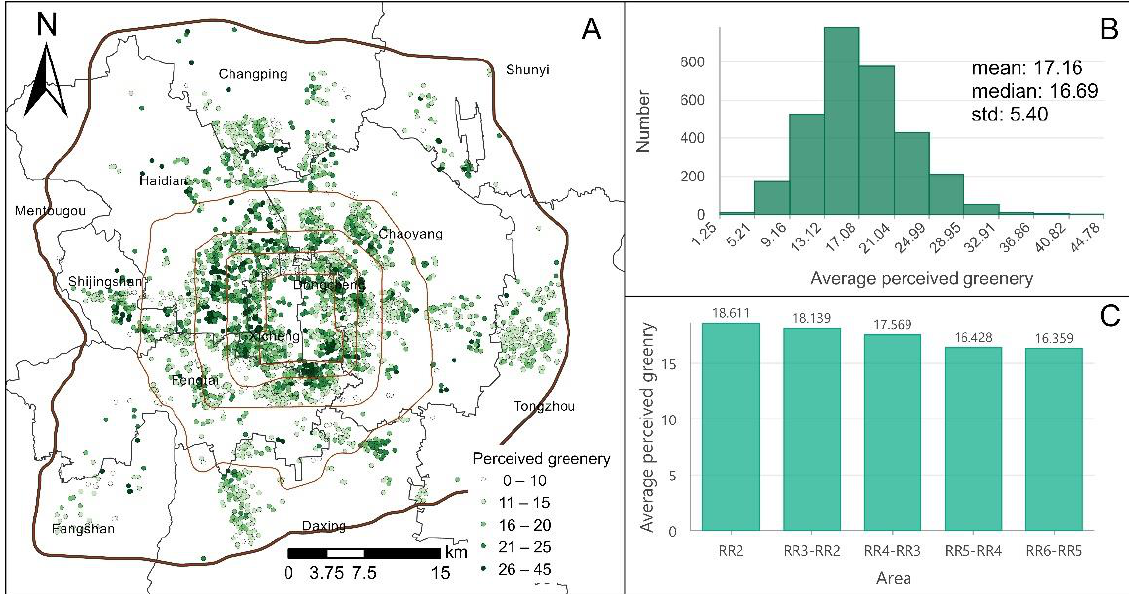
Figure 4. The perceived greenery distribution map and statistics in Beijing. Subplot ( A ): the perceived greenery distribution map. Subplot ( B ): the histogram and statistical results of average perceived greenery. The abbreviation “RR” in subplot ( C ) indicates ring roads, e.g., “RR3-RR2” indicates the Third to Second Ring Road areas.